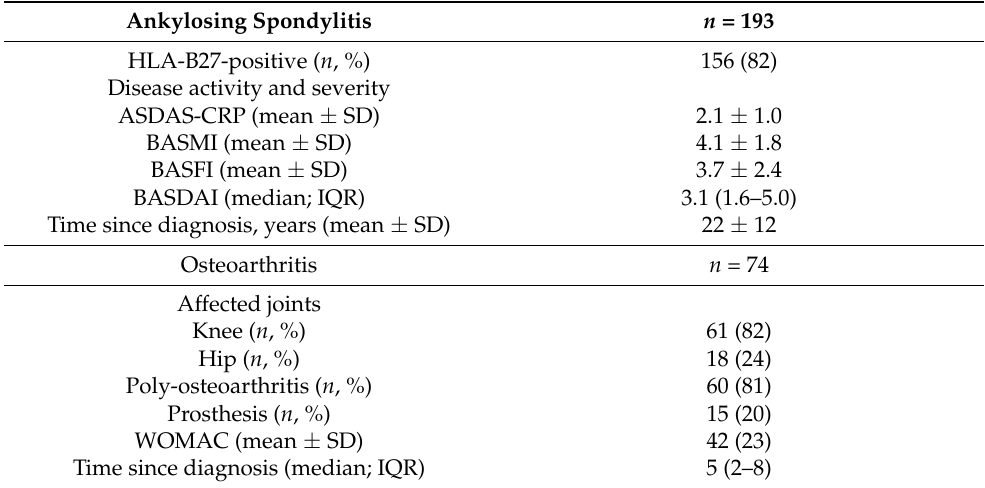
Table 2. Disease characteristics of AS and OA controls.